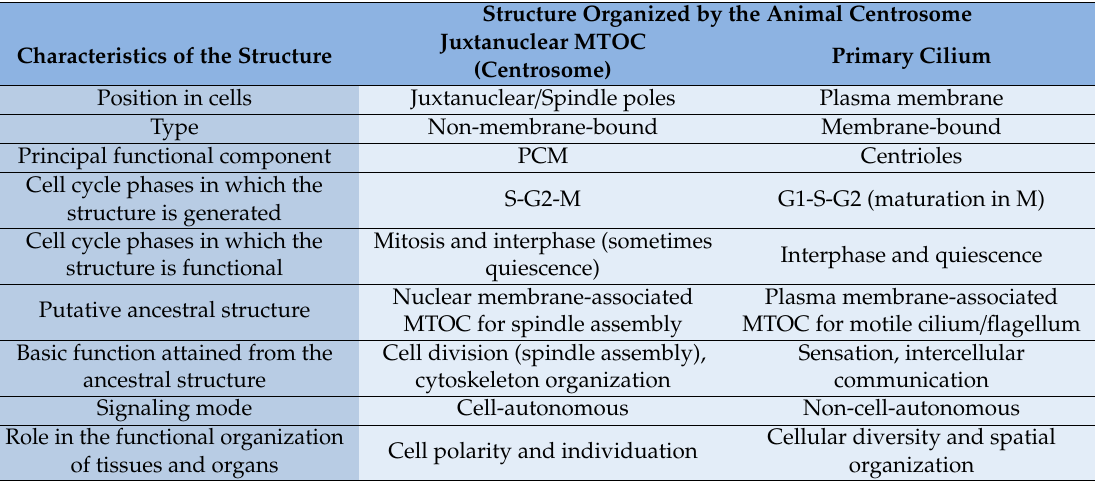
Table 1. Duality of the animal centrosome. Structure Organized by the Animal